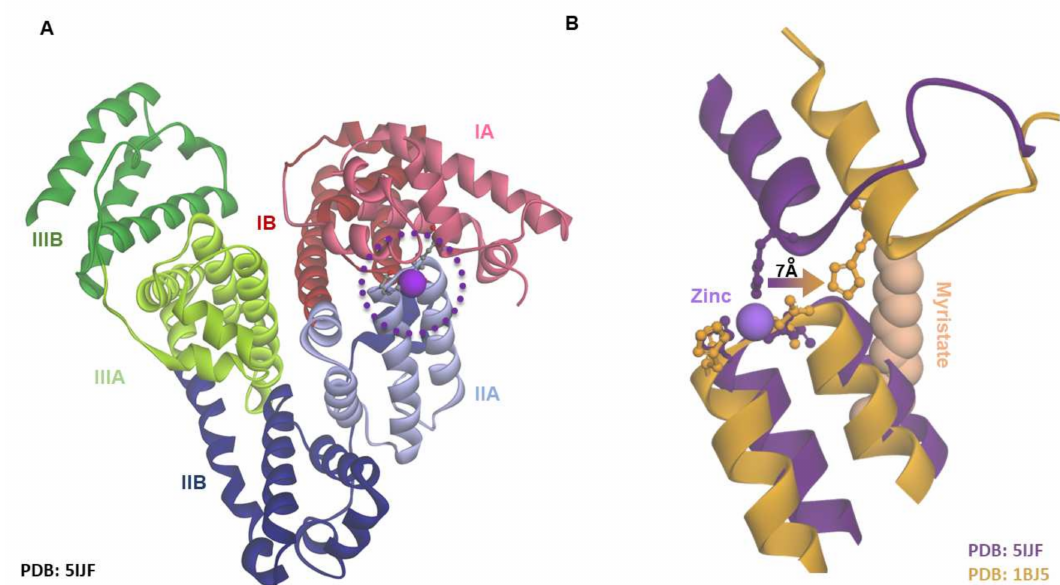
Figure 2. Zn 2+ and NEFA-binding to human serum albumin. ( A ). HSA complexed with Zn 2+ at the major Zn 2+ binding site (often known as site A; circled) located between domains I and II and composed of His67, His247, Asp249 and a solvent water molecule. ( B ). Binding of myristate alters site A, displacing His67 by ~7 Å relative to its position in the non-fatty acid bound structure. HSA possesses at least seven fatty acid-binding sites (FA1-7) of varying affinities [40,46]. Site FA2 is a high-affinity site located near to the primary Zn 2+ -binding site. Similar to the